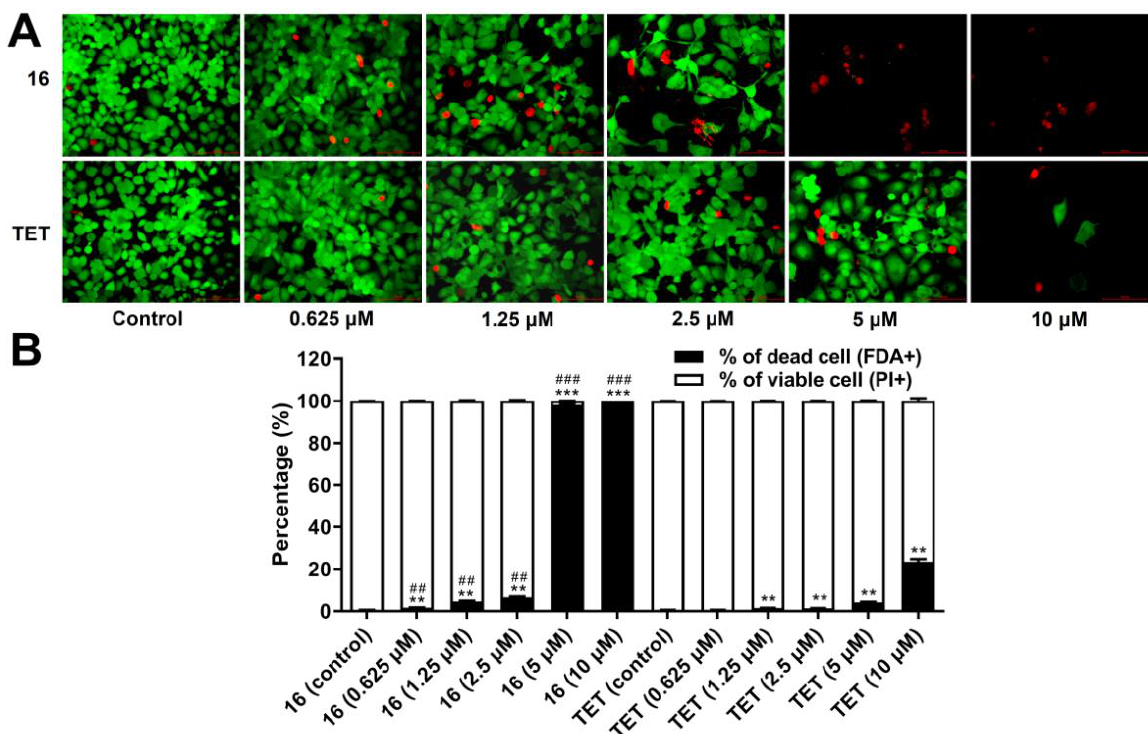
Figure 11. Effect of 16 on the cell death of HUVECs. ( A ) Figures of HUVECs stained with FDA/propidium PI. ( B ) Statistical analysis of dead cells induced by 16 . **: p < 0.01, ***: p < 0.001 vs. control; ## : p < 0.01, ### : p < 0.001 vs. TET at the same concentration.